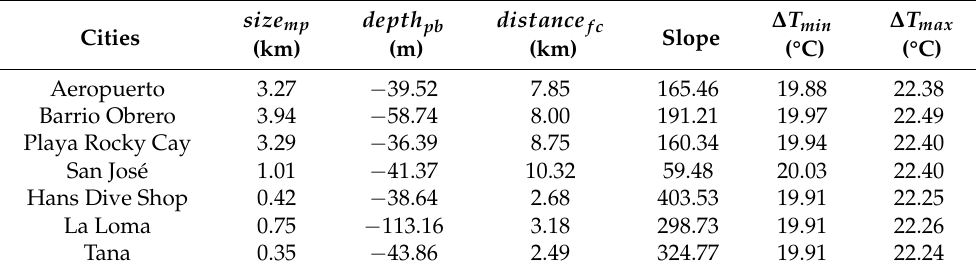
Figure 2. Bathymetric profiles around San Andrés Island, showing how high depths are reached near the coast. Table 2. Continental platform break in 7 points of San Andrés